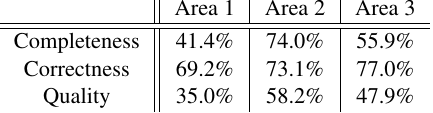
Figure 4: Pixel-wise result of class buildings (yellow = TP, red = FP, blue = FN)